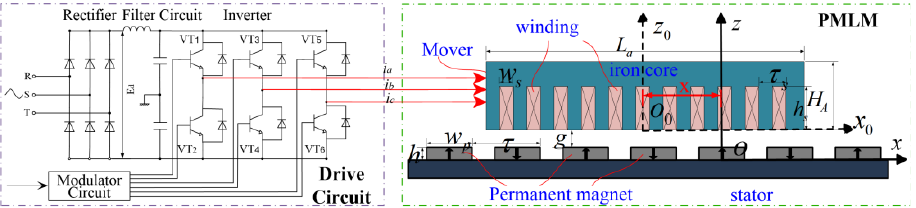
Figure 1. The analytical model of the direct drive feed system.